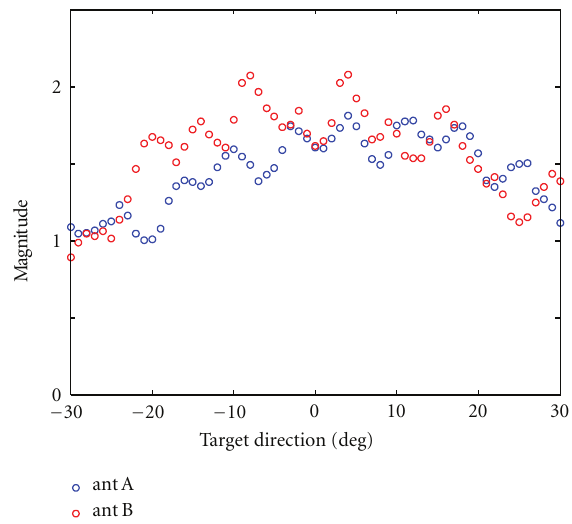
Figure 5: Magnitude of extracted multipath components corre- sponding to di ff erent angles in anechoic chamber